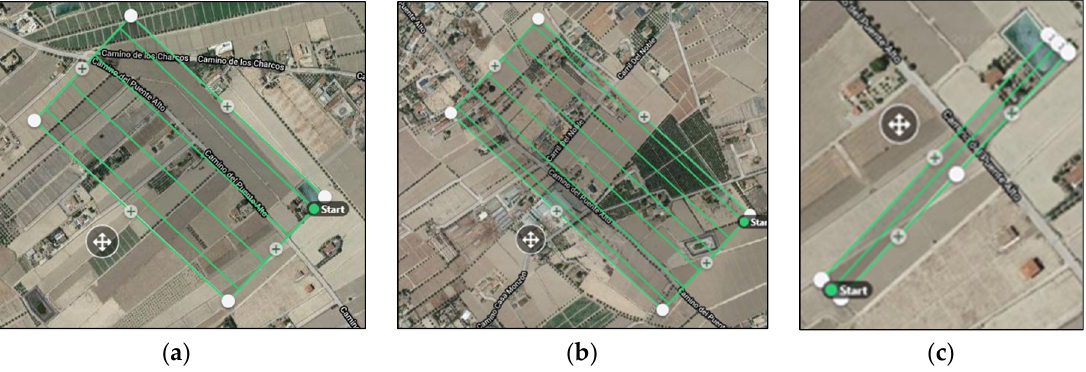
Figure 5. The flight programming was initially carried out with the DroneDeploy application: ( a ) Phantom 3 Pro, Block 1; ( b ) Inspire 2, Block 3; ( c ) cross strip Inspire2, Block 1.